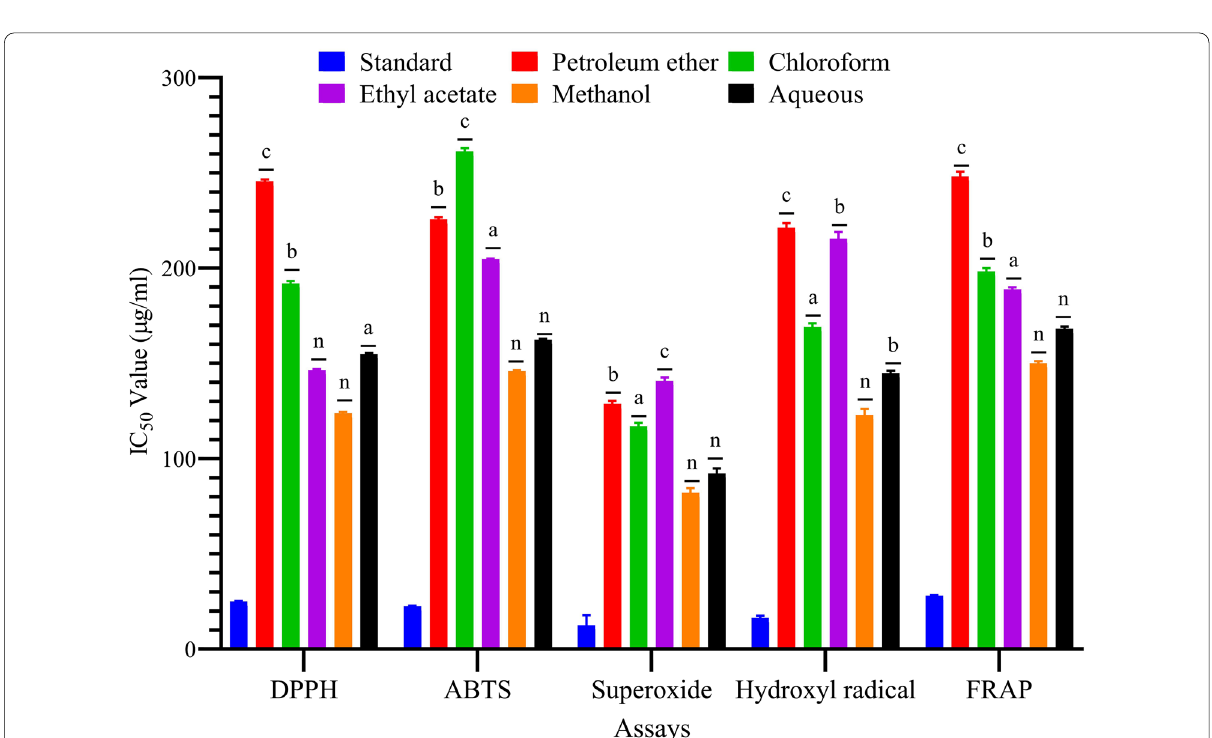
Fig. 3 In vitro antioxidant activity of E. ramosissimum Desf. stem extracts by DPPH, ABTS, superoxide, hydroxyl radical scavenging, and FRAP assays. Different letters in the graph indicate significant differences ( a